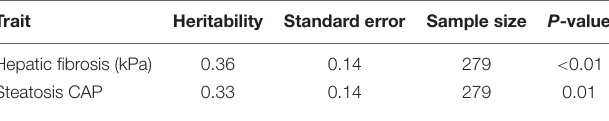
TABLE 2 | Heritability analysis of FibroScan